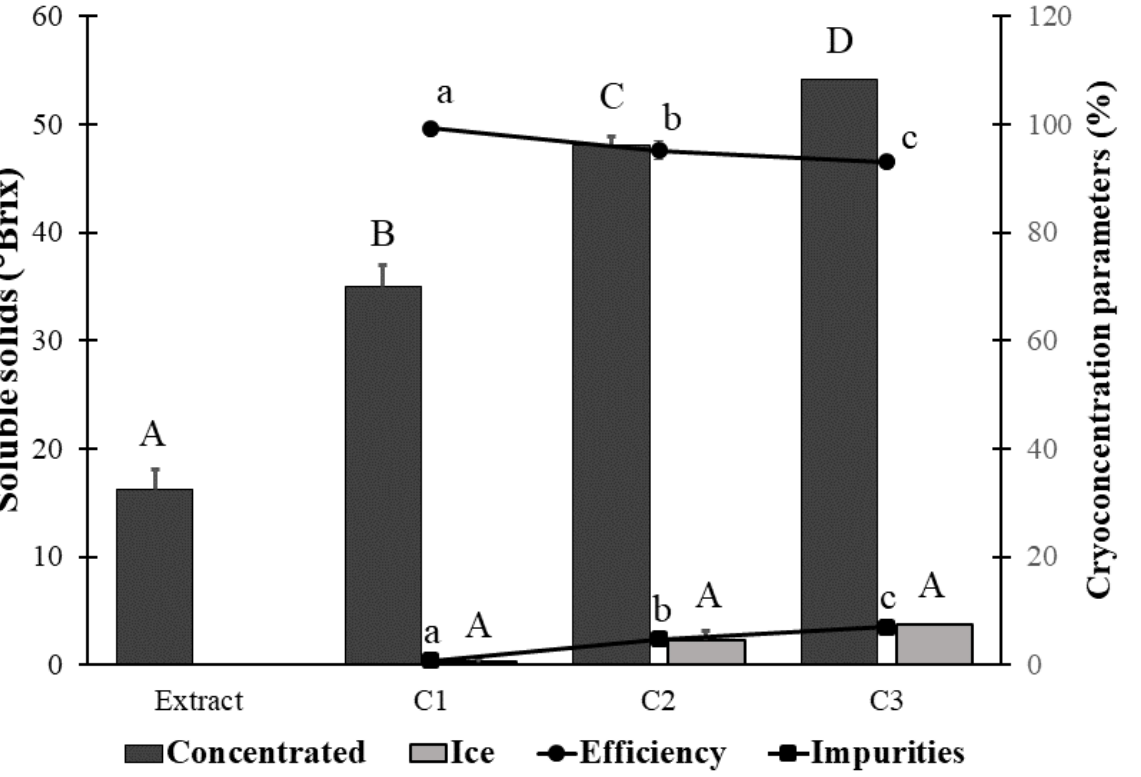
Figure 1. Soluble solid content (concentrate and ice) and cryoconcentration parameters (efficiency and impurities) after each centrifugation–filtration cycle. Extract A; C1: cryoconcentrate obtained from the first cycle; C2—cryoconcentrate obtained from the second cycle; C3—cryoconcentrate obtained from the third cycle. Different capital letters over the bars indicate a significant difference ( p ≤ 0.05 for soluble solid content (concentrate and ice)) and different low letters indicate a significant difference ( p ≤ 0.05 for cryoconcentration parameters (efficiency and impurities)) after each centrifugation– filtration cycle, according to Tukey’s